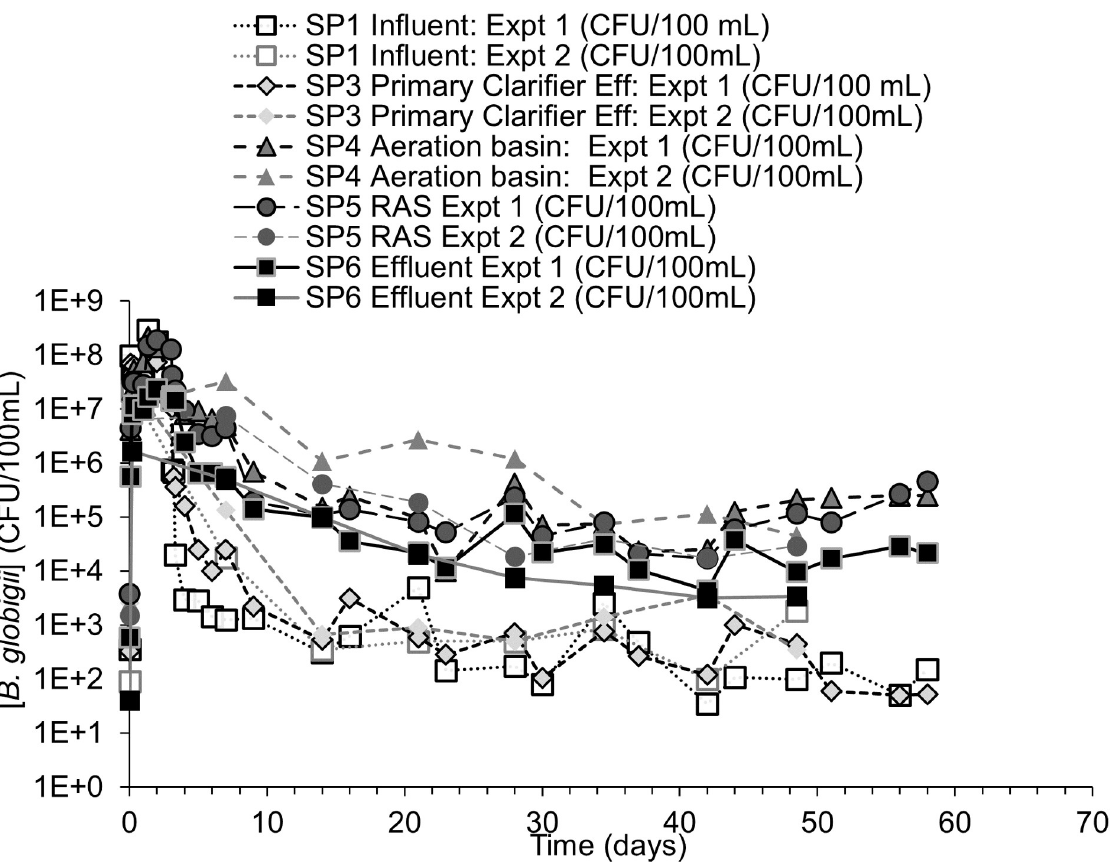
Fig 3. globigii concentration response curves for Test 1 and 2. B . Concentration-time plot of individual sample ports over time for experiment 1 and experiment 2.